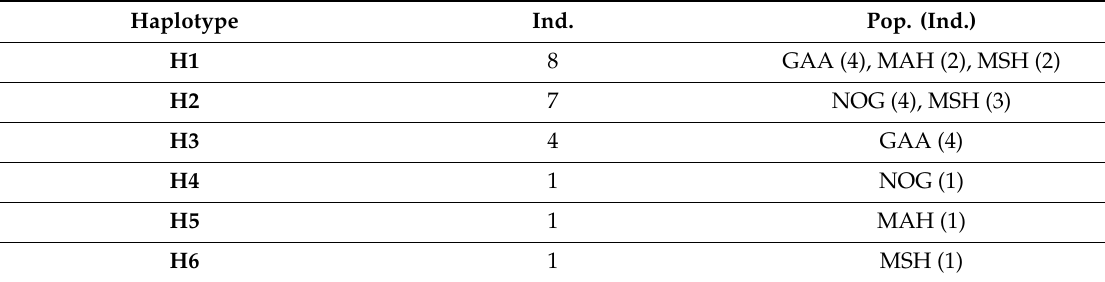
Table A2. Information of network haplotype composition of invasive A. franciscana populations.